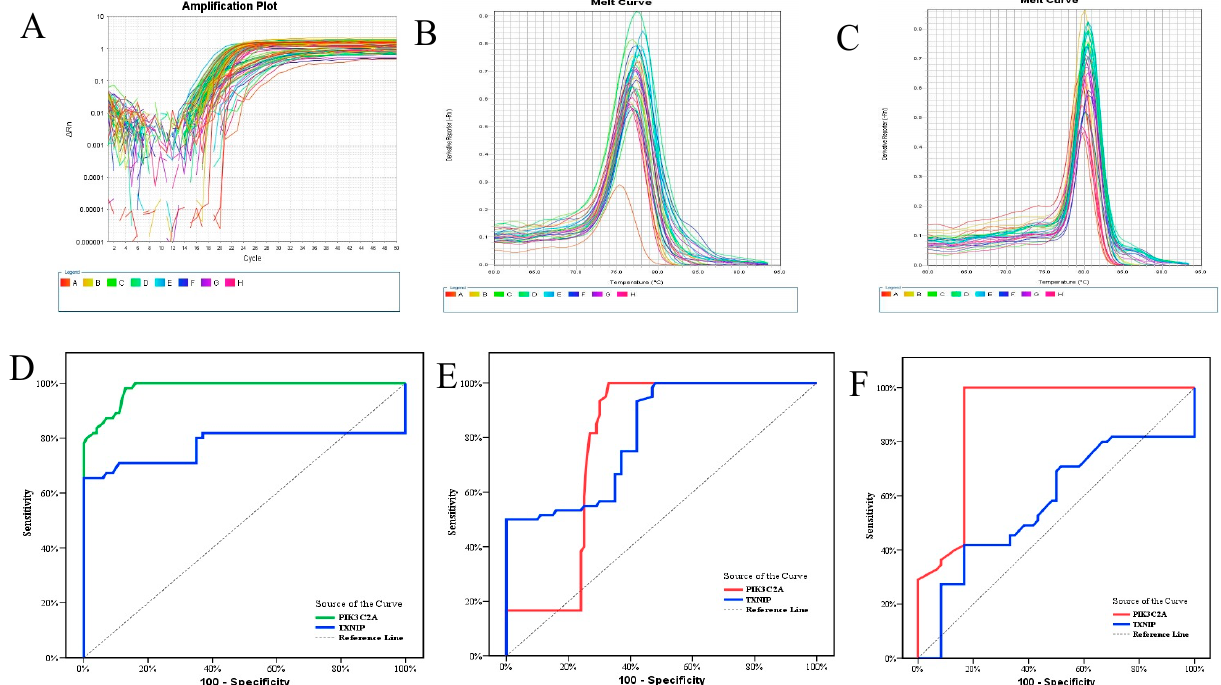
Figure 1. ( A ) Amplification plot of PIK3C2A& TXNIP (Rn vs. Cycle) ( B ) Melt Curve of PIK3C2A ( C ) Melt Curve of TXNIP ( D ) ROC curve for PIK3C2A and TXNIP to diagnose Acute Coronary Syndrome (ACS) from control ( E ) ROC curve for PIK3C2A and TXNIP to diagnose Chronic Stable Angina (CSA) from control ( F ) ROC curve for PIK3C2A and TXNIP to diagnose Acute Coronary Syndrome (ACS).